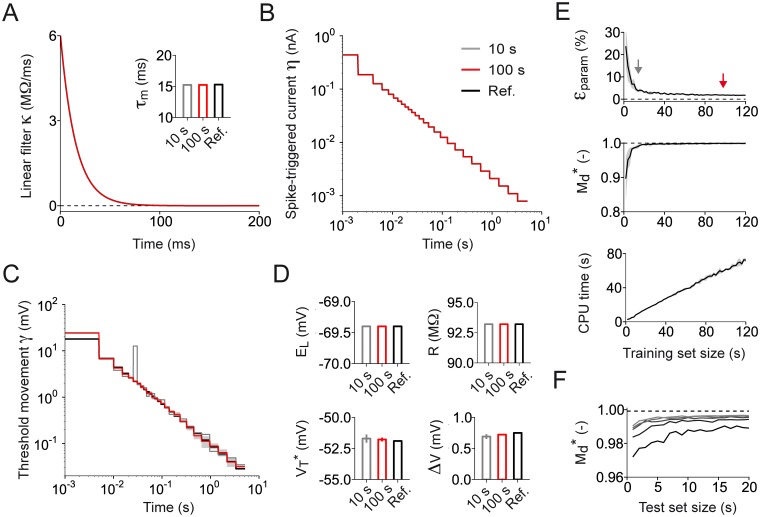
Validation of the procedure used for GIF model parameter extraction.
(A)-(D) GIF model parameters used to generate the artificial data (black) recovered using a training set of T
tr = 10 s (gray) and T
tr = 100 s (red). Error bars and shaded areas represent one standard deviation obtained using five different data sets. In case of perfect agreement, black lines, gray lines and shaded areas are not visible. (A) Membrane filter κ(t). Inset: membrane timescale τ
m = C/g
L. (B) Spike-triggered current η(t). (C) Spike-triggered movement of the firing threshold γ(t). (D) Reversal potential (E
L, top left); cell resistance (R=gL−1, top right); threshold baseline (VT*, bottom left) and threshold sharpness (ΔV, bottom right). (E) Estimation error ϵ
param on model parameters (upper panel), performance on spike-timing prediction Md* (middle panel) and computing time required for parameter extraction (lower panel) as a function of the training set size T
tr. Gray areas indicate one standard deviation across different artificial datasets generated using the same reference parameters. Gray and red arrows indicate the performance obtained with a training set of 10 s and 100 s, respectively. (F) Reliability of the validation procedure as a function of the number of repetitions n
test and the duration T
test of the test current. For different values of n
test and T
test, Md* was computed 1000 times using different test currents. Consistent with the result that Md* corrects the small-sample bias, the mean value of Md*=0.998 (dashed line) obtained across repetitions of different test currents did not depend on n
test and T
test. The continuous lines represent the 0.25-quantiles of the Md* distribution obtained with n
test = {3,6,9,12,15} (from dark to light gray) and indicate that the reliability of the measure increases with n
test and T
test.